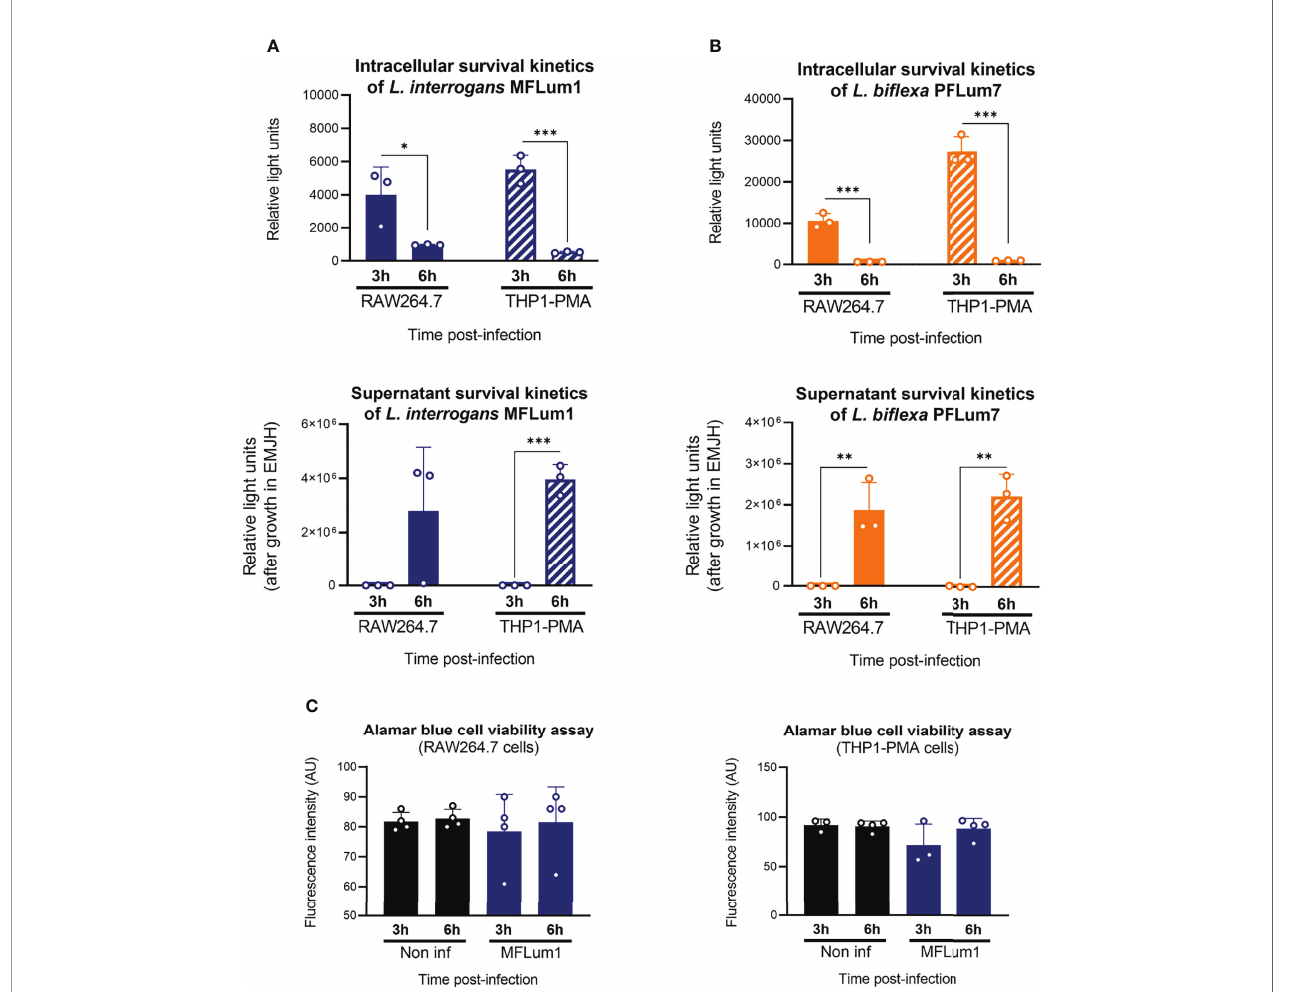
FIGURE 7 | Internalized leptospires seem to exit both human and murine macrophages. (A, B) Intracellular and supernatant survival 3 and 6 h post-infection of (A) L. interrogans serovar Manilae strain MFLum1 and (B) L. bi fl exa serovar Patoc strain Patoc I in RAW264.7 and THP1 – PMA cells infected during 1 h with subsequent gentamicin protection assay. Intracellular survival was directly assessed by luminescence measurement on cell lysates diluted in EMJH. Supernatant survival was indirectly measured by monitoring leptospiral growth from cell lysates diluted in EMJH at OD 420 nm. (C) RAW264.7 and THP1 – PMA cell viability measured by Alamar Blue assay in the same infection conditions. (A – C) Bars correspond to mean +/- SD of technical replicates ( n > 3). Data presented are representative of at least two independent